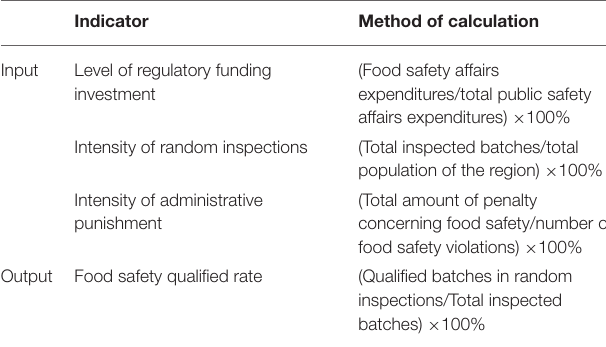
TABLE 1 | Explanation of the evaluation indicators of food safety supervision